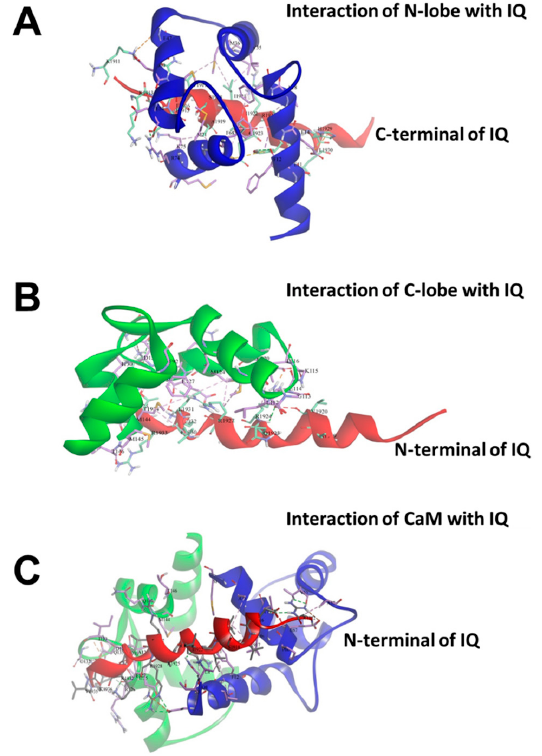
Figure 4. Interaction of the N-lobe/C-lobe of CaM with Na V 1.1 IQ domain by docking experiment. ( A ) The lowest interaction energy pose for the interaction of N-lobe of CaM with Na V 1.1 IQ domain; ( B ) The lowest interaction energy pose for the interaction of C-lobe of CaM with Na V 1.1 IQ domain; and ( C ) The lowest interaction energy pose for the interaction of the N-lobe and C-lobe of CaM with Na V 1.1 IQ domain. Red ribbon—Na V 1.1 IQ; blue ribbon—N-lobe; green ribbon—C-lobe. Interaction residues and nonbond interactions are indicated as well.